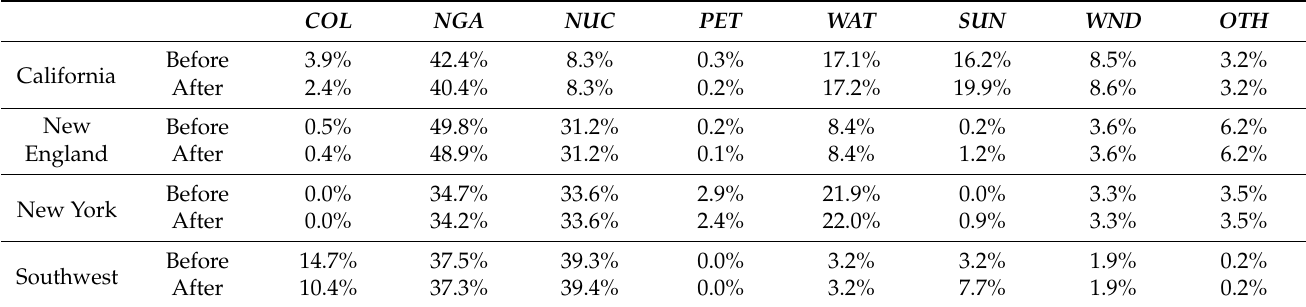
Table 6. 25% solar penetration—Generation by region and sources before and after adding the hypothetical solar plants.